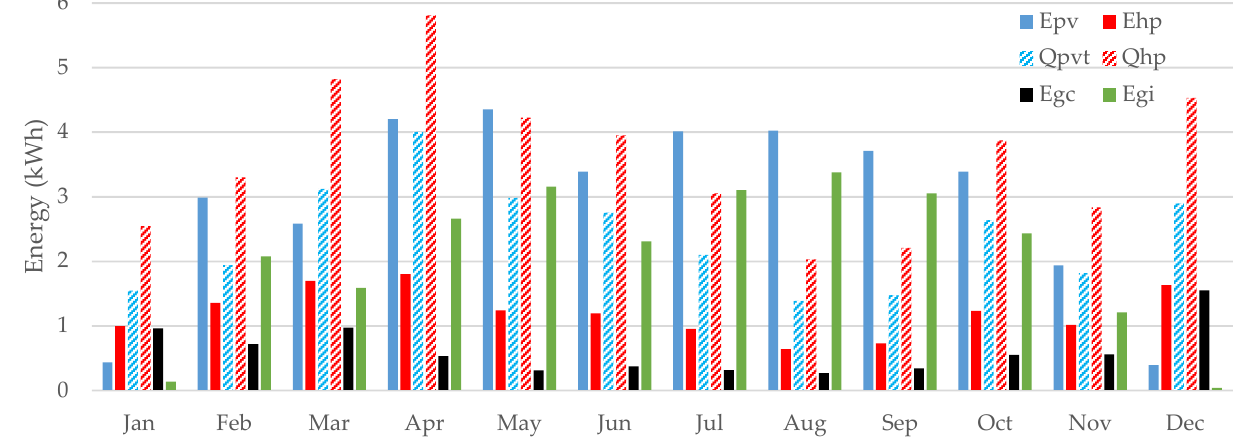
Figure 13. Monthly average daily mean energy magnitudes.